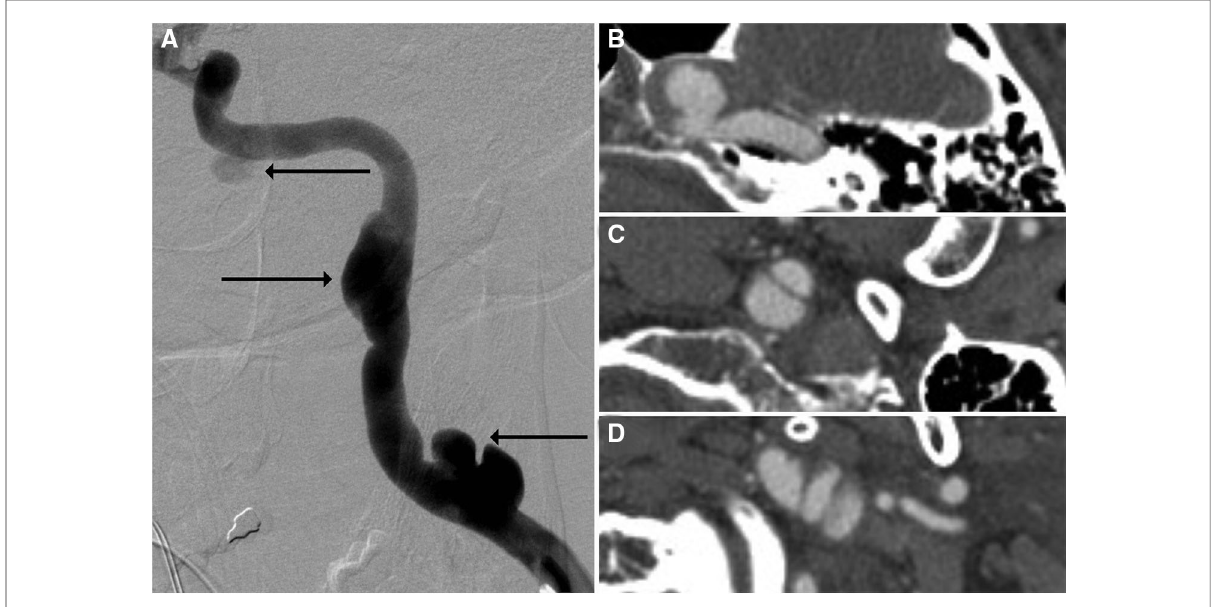
FIGURE 4 Imaging of a 52-year-old man who presented with headache. DSA ( A ) and CTA ( B – D ) showed multiple pseudoaneurysms related to previous dissection involving the left cervical and petrous internal carotid artery segments, with arrows on DSA corresponding to CTA